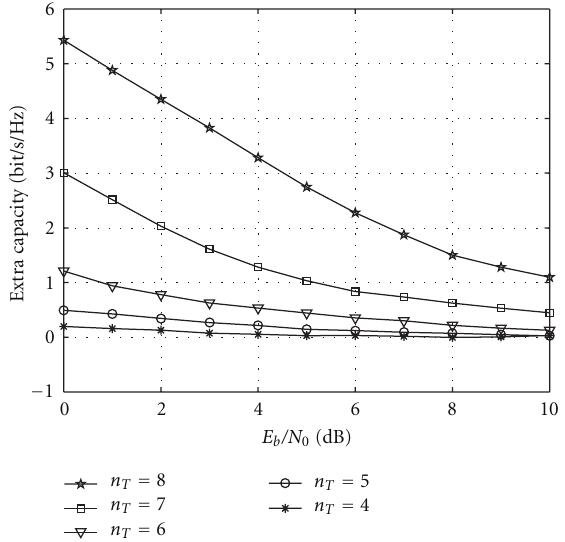
Figure 4: Extra capacity results between modified and traditional Turbo-BLAST systems with eight receive antennas and various transmit antennas configuration under the conditions of imperfect = 0 . 01). CSI ( σ 2 e